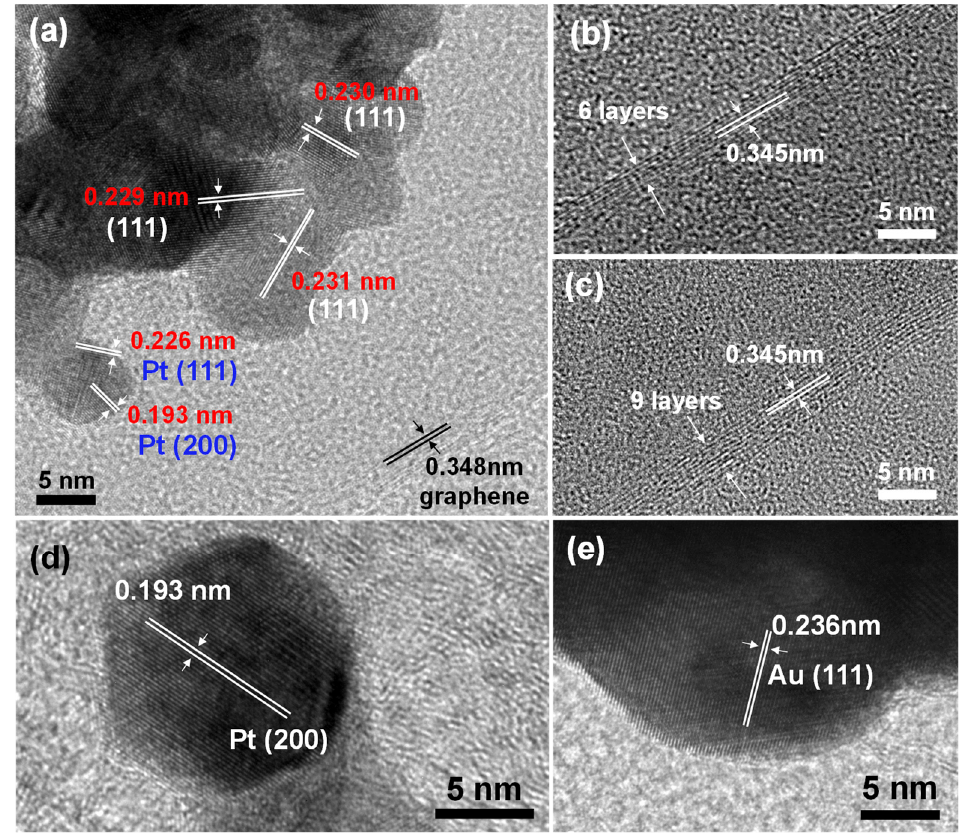
Figure 3. ( a ) HRTEM images of the TG/Au 52 Pt 48 ; ( b , c ) HRTEM images taken on the wall-edges of the TG/Au 52 Pt 48 at different areas; ( d , e ) HRTEM images of the TG/Pt 0.241 and TG/Au 0.258 , respectively. Figure 4 shows the Raman spectra acquired on surfaces of the TG, TG/Au 0.258 , TG/Pt 0.241 , and TG/Au 52 Pt 48 catalysts. The bare TG contained three Raman characteristic